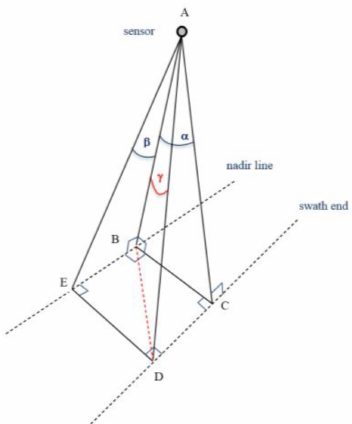
Figure 1. Calculation of net scan angle γ ( ˆ BAD ). A represents the sensor position. B represents the nadir point or the point return at zero mirror scan angle in vertical channel C2. E represents the point return at zero mirror scan angle in tilted channels C1 or C3. α = mirror scan angle ( ˆ BAC = ˆ EAD ). β represents the inclination of the scanning plane (here EAD plane) for any of the tilted channels (C1 or C3). BC = ED represents the distance between the nadir line (BE) and the interception position (C or D) when mirror scan angle = α .